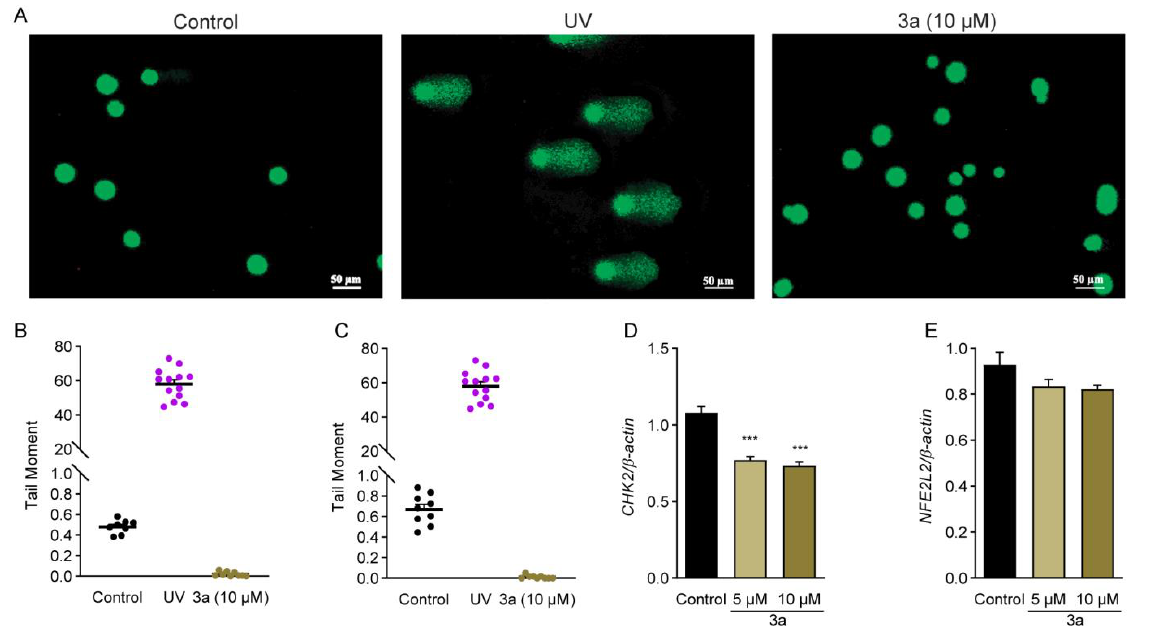
Figure 6. G2/M arrest and cell death induced by 3a is not associated with DNA damage . ( A ) Repre- sentative images of the nucleoids from the cells treated with 3a for 24h analyzed by Comet assay. ( B , C ) Comet assay analysis showing DNA damage indices represented by the Tail Moment after 12 and 24 h of treatment with 3a . UV radiation was used as a positive control. ( D , E ) Relative mRNA expression of CHK2 and NFE2L2, respectively, determined by qPCR in SK-MEL-147 cells treated with 3a at 5 or 10 µM for 24 h. *** p < 0.001 according to ANOVA followed by Dunnet post-test compared with control group.